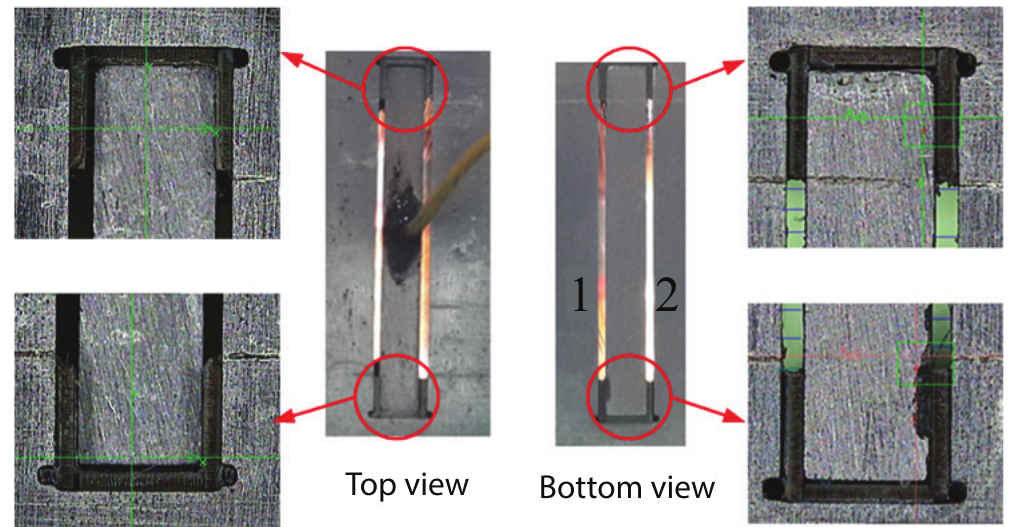
Figure 6. A closer look at the top and bottom views of the valve’s epoxied ceramic slides and metal anode is